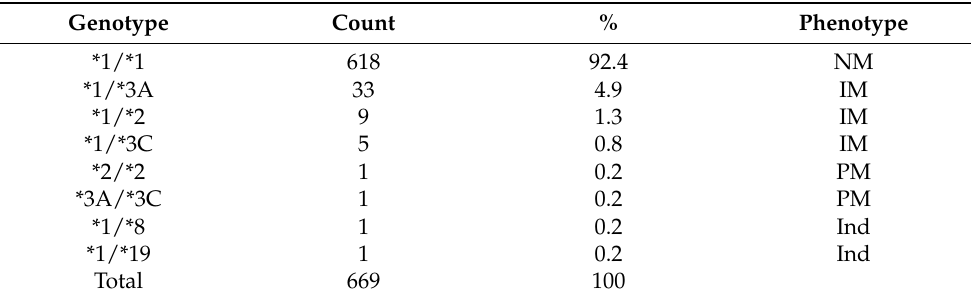
Table 2. Prevalence of TPMT genotypes in a Spanish